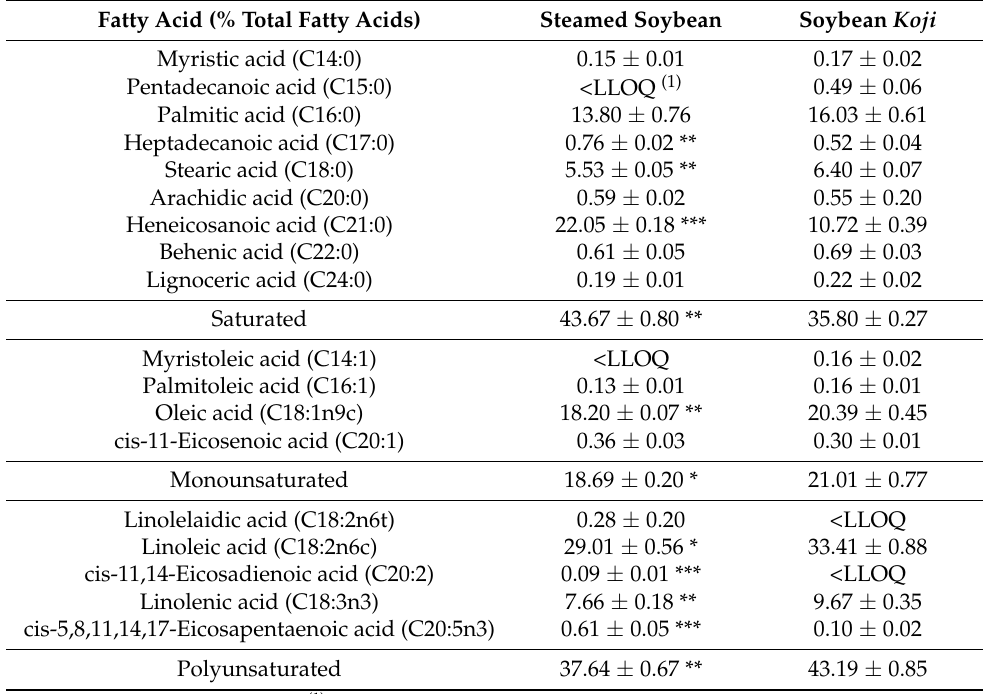
Table 5. Fatty acid composition in steamed soybean and soybean koji . Fatty Acid (% Total Fatty